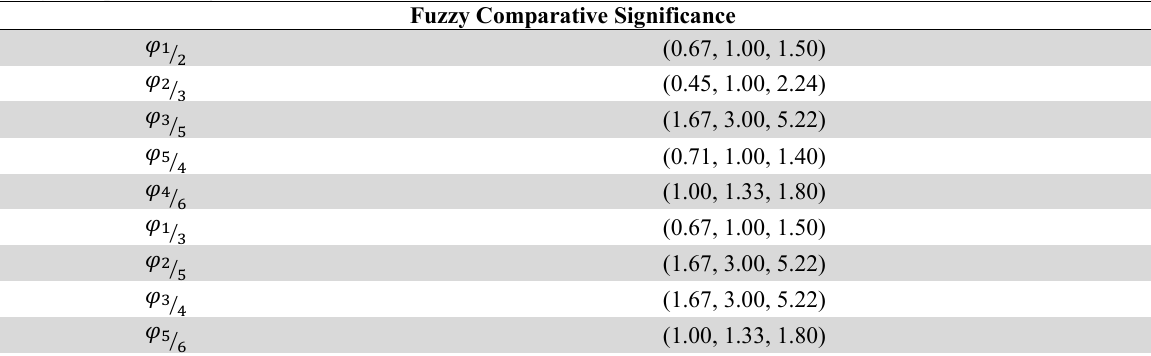
Fuzzy Comparative Significance